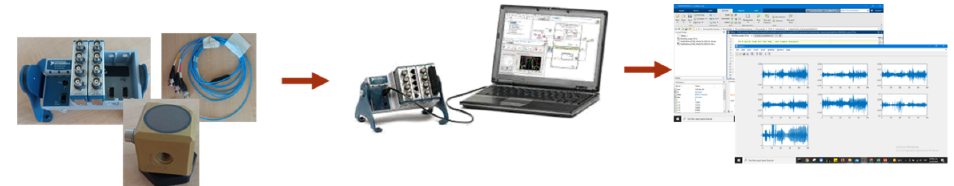
Figure 8. Measurement and data acquisition system. to the length of the deck. Measurements were taken in the gravitational (Z) and transverse (X) directions of the deck (Figure 9).